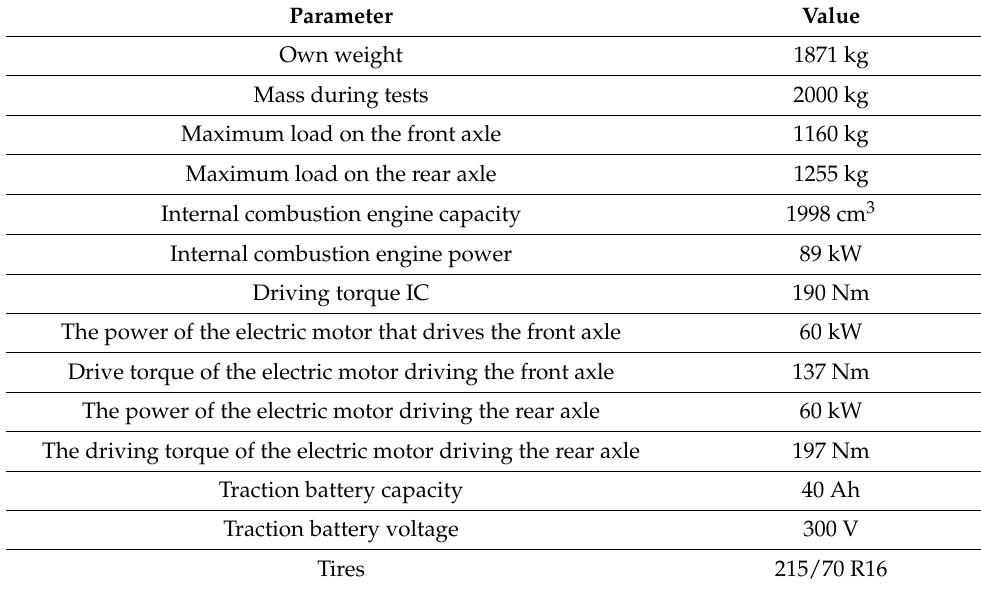
Table 2. Technical parameters of the vehicle intended for experimental